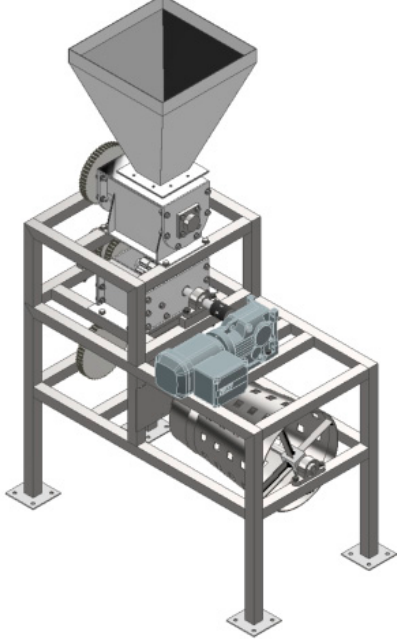
Figure 9. Final design: automatic shell cracking machine.